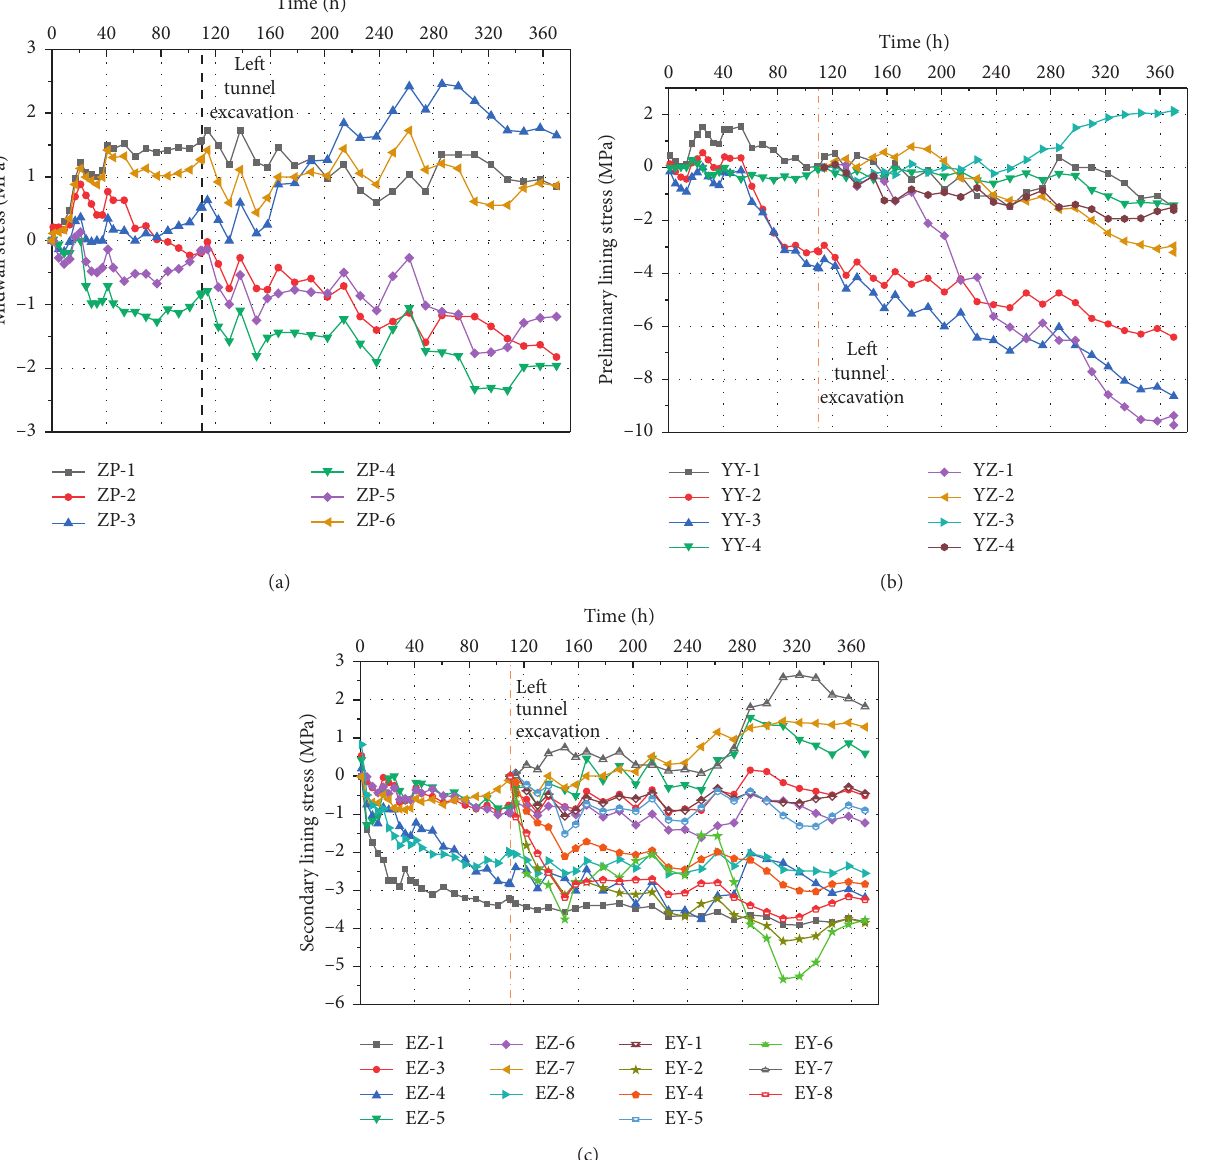
Figure 10: Time history curves of structural internal stresses. (a) Stress history curve of midwall. (b) Stress history curve of preliminary lining. (c) Stress history curve of secondary